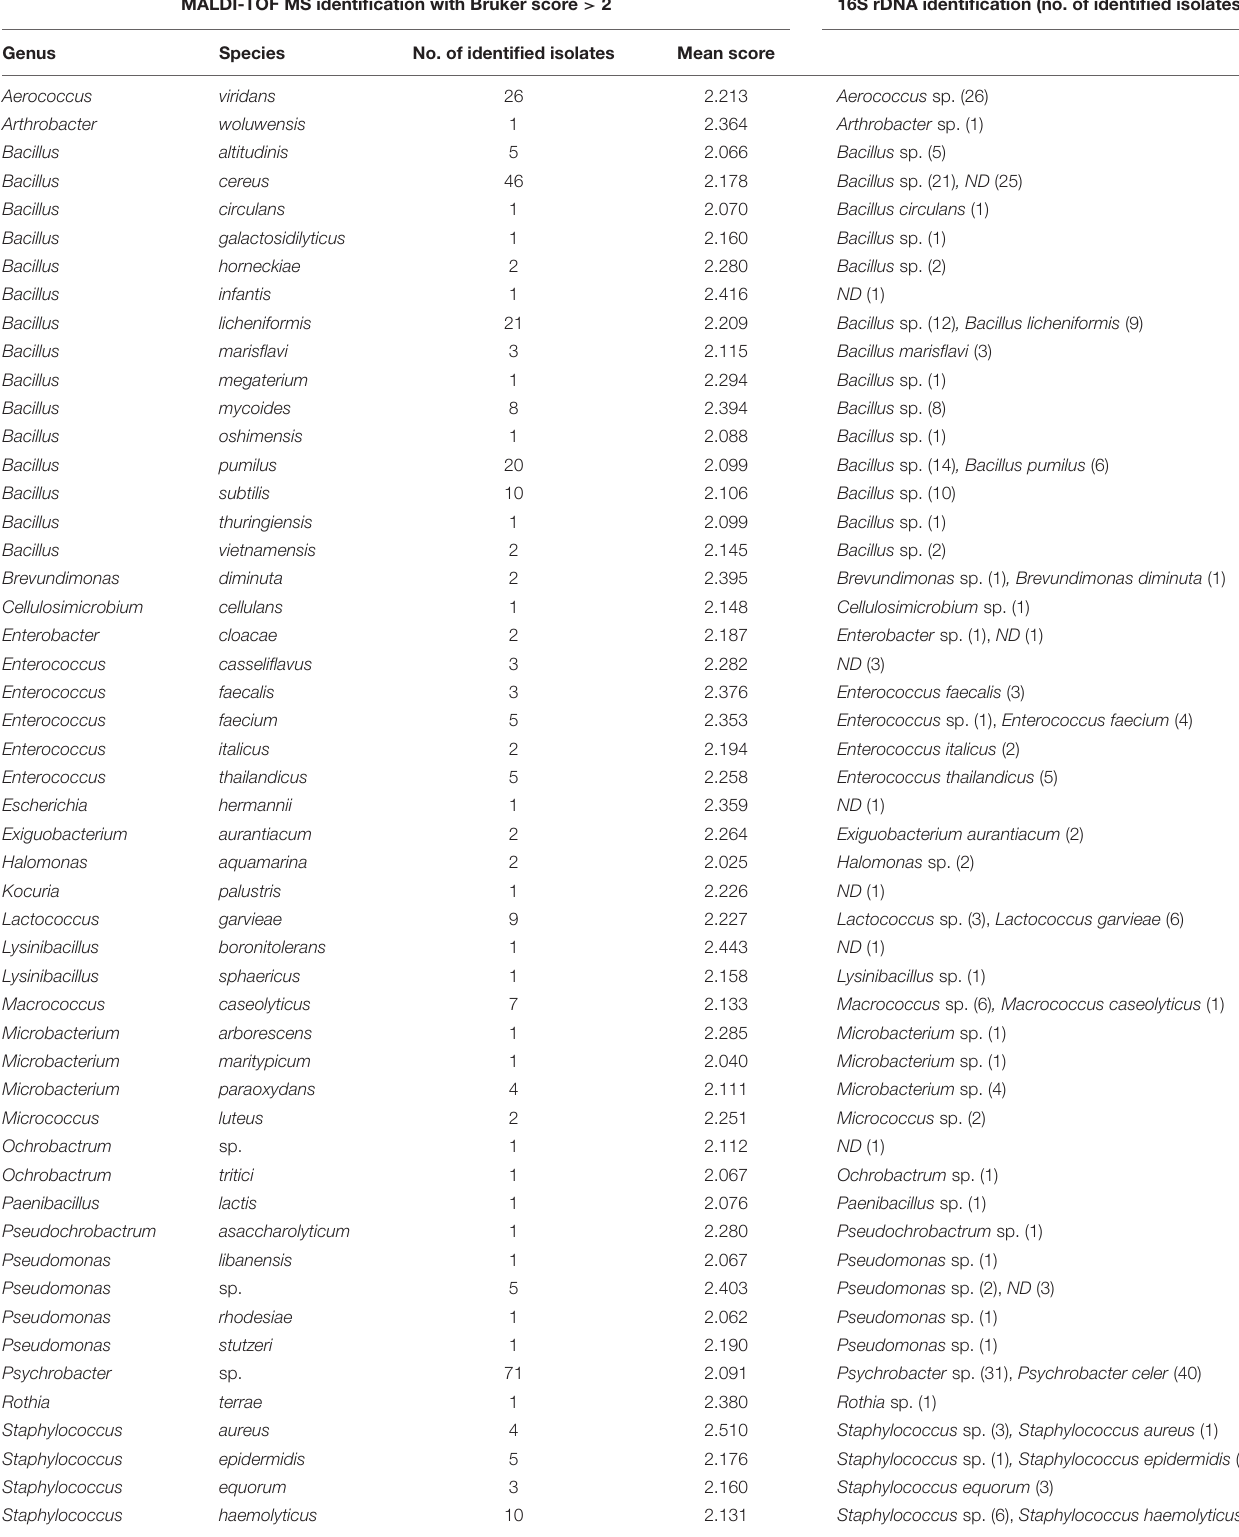
TABLE 1 | Identification of isolates by 16S rDNA technique and by MALDI TOF method with Bruker score > 2. MALDI-TOF MS identification with Bruker score > 2 16S rDNA identification (no. of identified